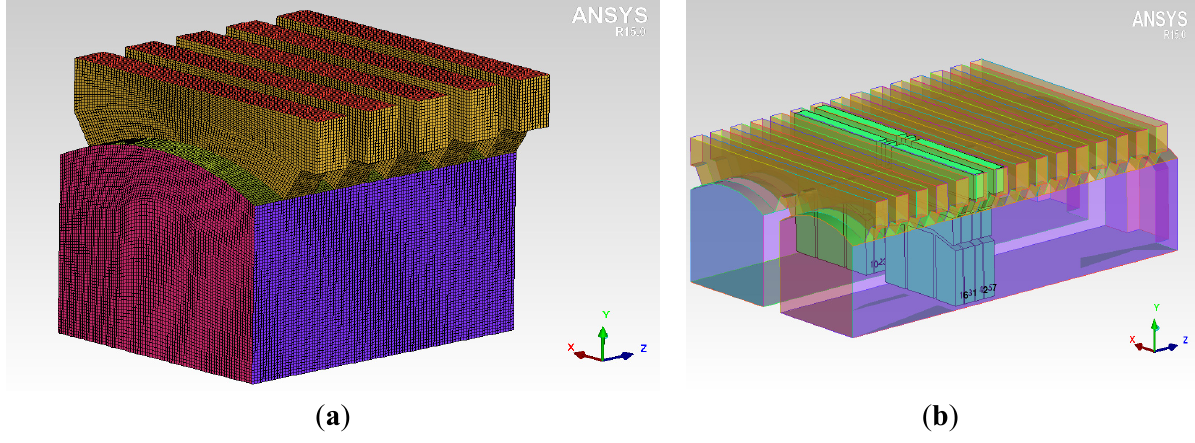
Figure 6. Blocking approach ( a ) and resulting mesh ( b ) for the bottom